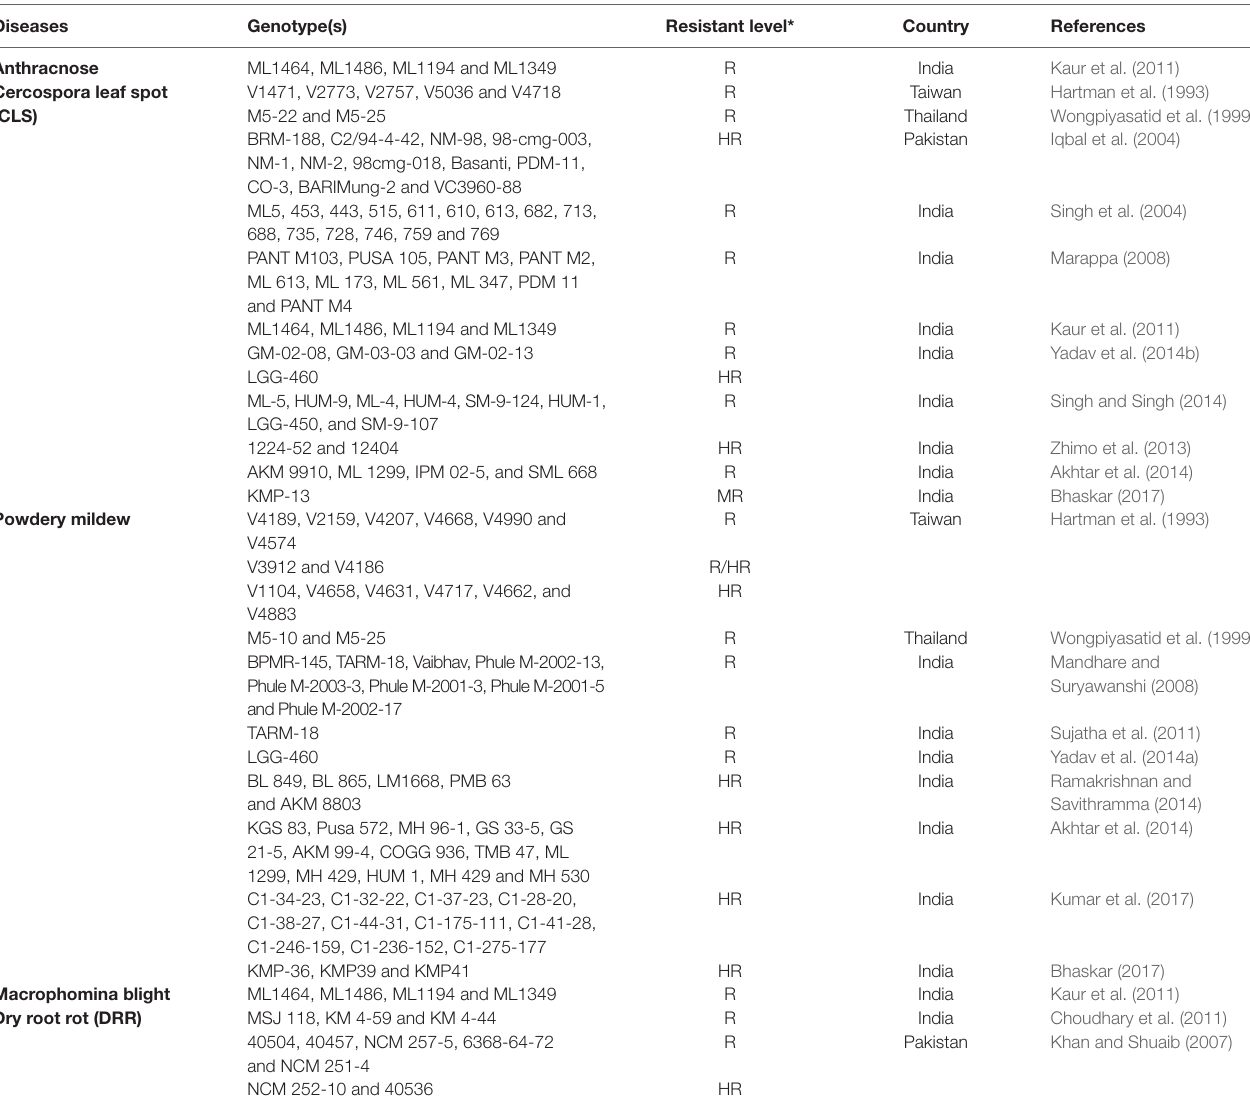
TABLE 2 | Resistant genotypes of mungbean against fungal diseases. Diseases Genotype(s) Resistant